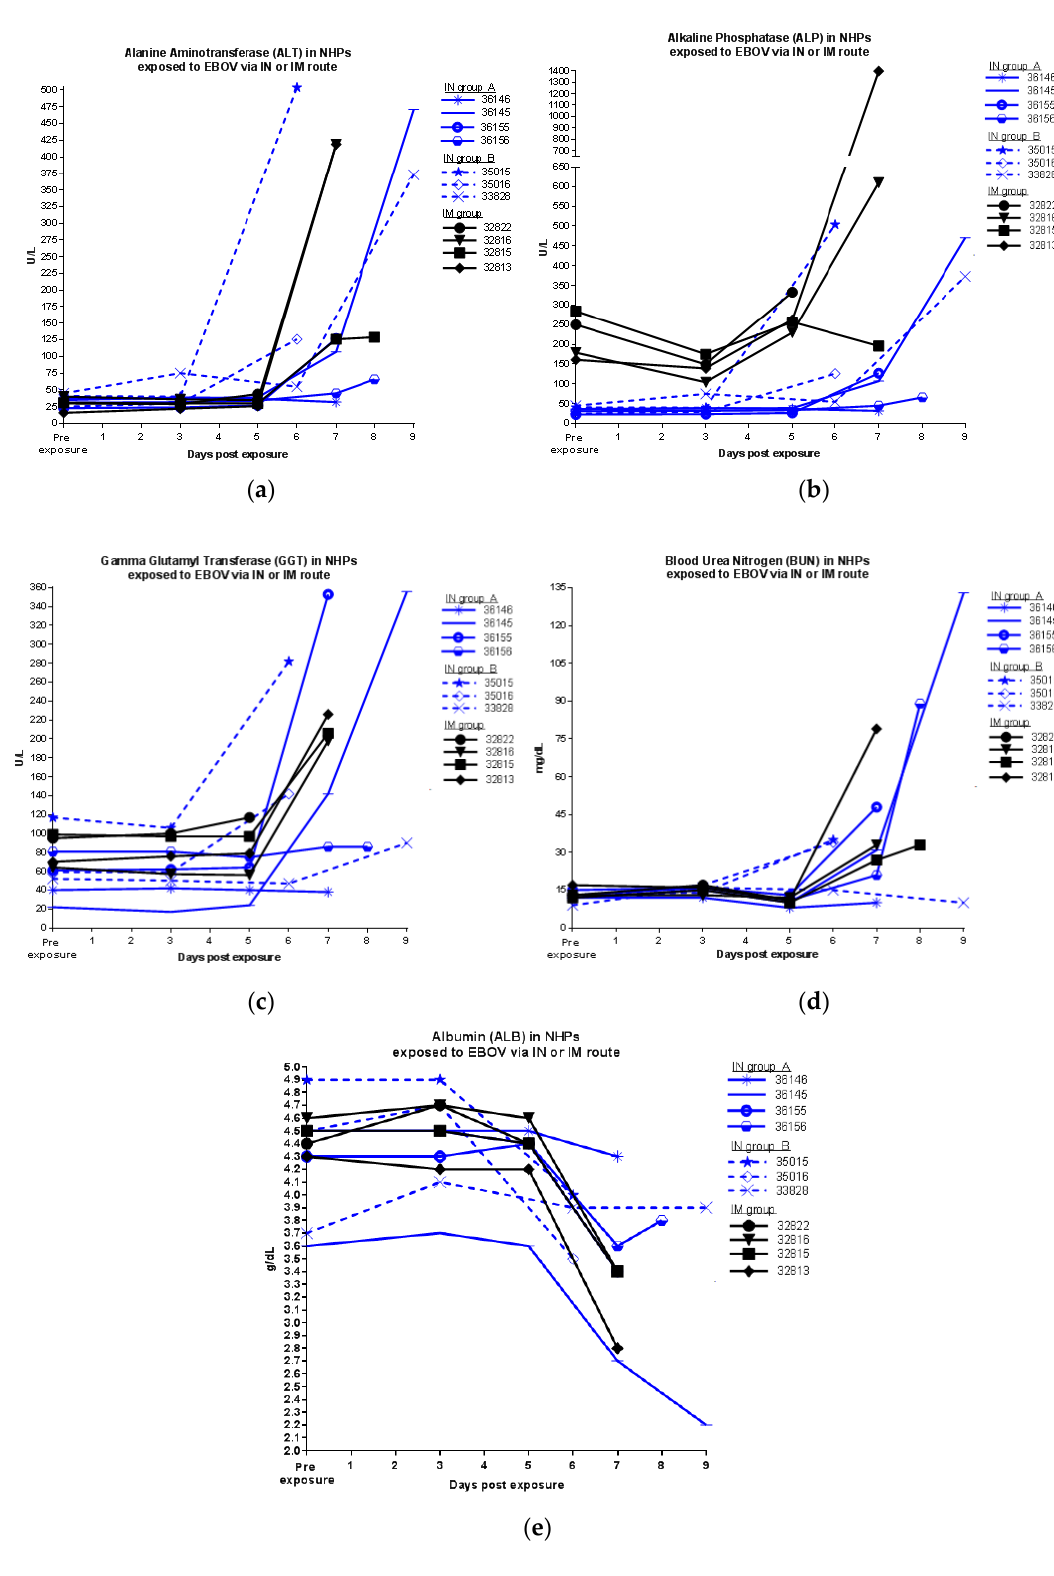
Figure 4. Blood chemistry of NHPs exposed to EBOV via IN or IM route; ( a ) ALT; ( b ) ALP; ( c ) GGT; ( d ) BUN; ( e ) ALB.